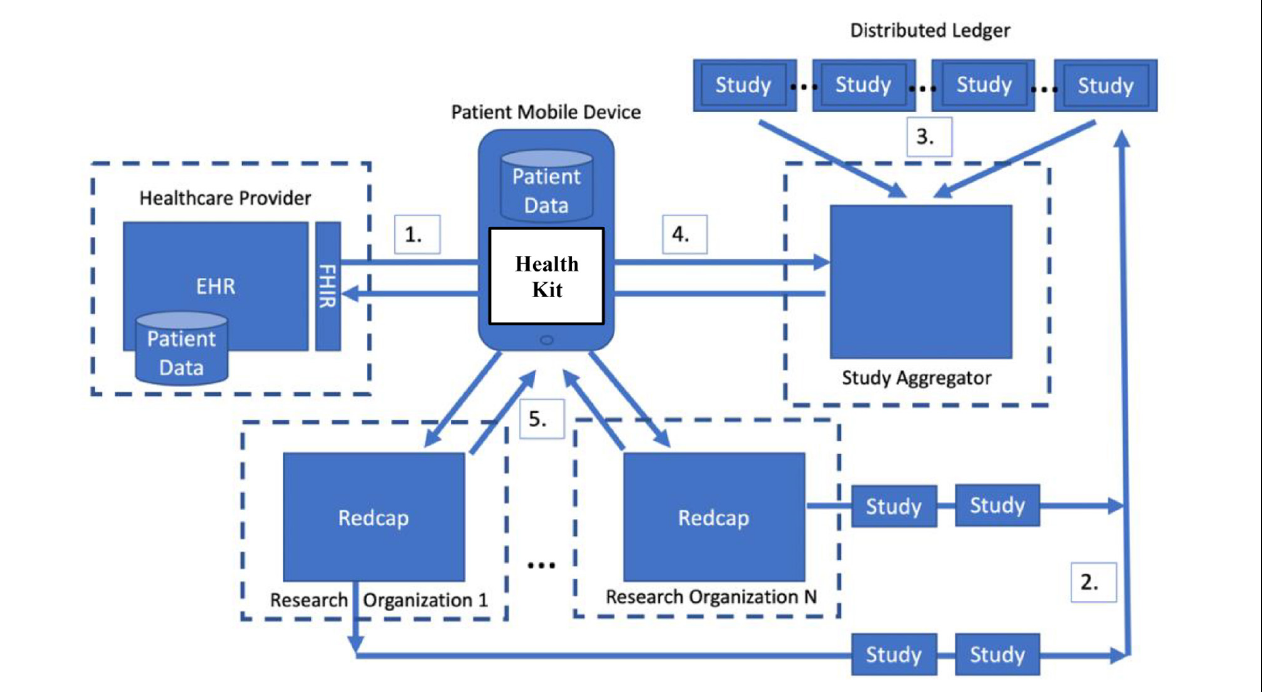
FIGURE 1 | An architecture for enabling patient-centric stewardship of research data using a distributed ledger.